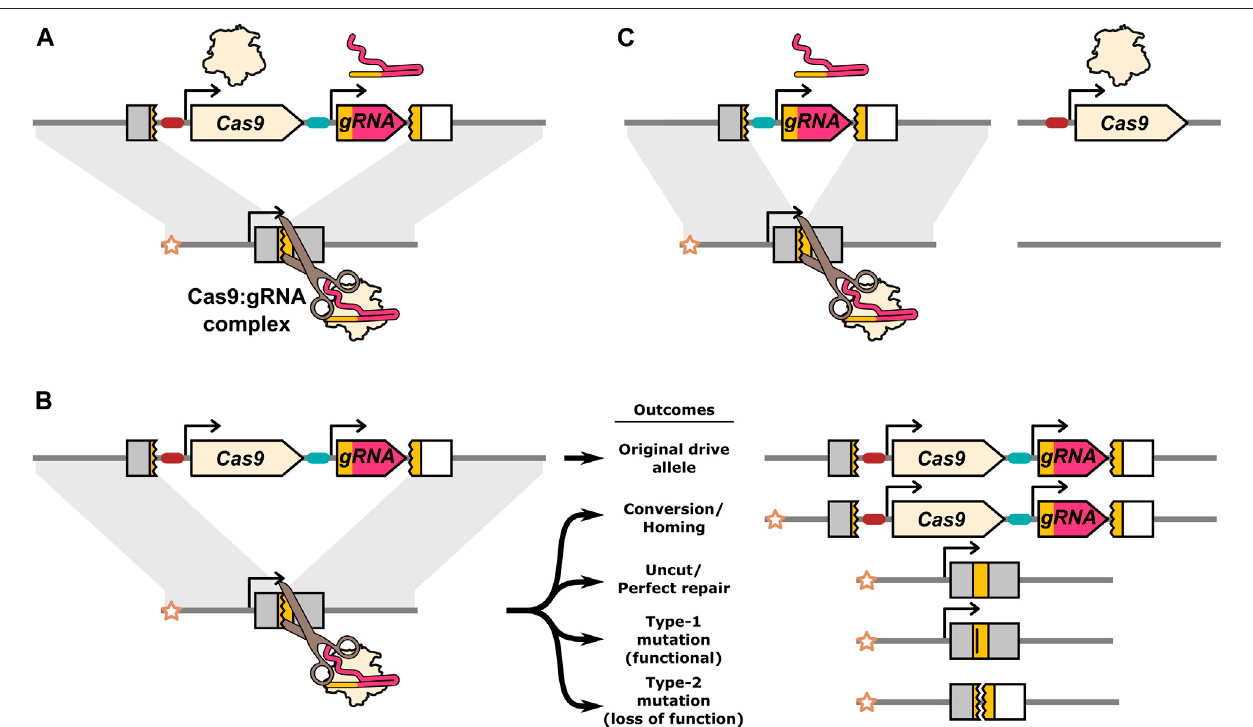
FIGURE 1 | Illustration of the Cas9: gRNA homing endonuclease gene drive inheritance biasing mechanism and potential DNA repair outcomes. (A) The drive expresses Cas9 and a gRNA which together form a complex that fi nd and cleave the target allele. (B) DNA breaks can be resolved by a range of different repair outcomes. Conversion occurs when HDR uses the homologous chromosome carrying the drive allele as a repair template. The star indicates the “ recipient ” chromosome, and allows the original drive allele to be distinguished from a drive allele produced by homing. Alleles that are cut and repaired perfectly, as well as uncutalleles,remainunconverted.Inadditiontoconversion,DNArepaircanalsoresultinmutationsinthetargetgene.Ifthespeci fi cmutationsdonotdisruptthefunction of the target gene they are classi fi ed as type-1. If the mutations do prevent normal function of the target gene they are classi fi ed as type-2. (C) A componentessential to theinheritancebiasingprocesssuchasthegRNAorCas9genecanbelocatedonaseparateelementproducinga “ split-drive ” con fi guration.ThegRNAtargetsequence in the endogenous target gene is indicated by a yellow colouring. The target gene is shaded grey, unless disrupted by the drive or type-2 mutations at which point it is shadedwhitetoindicateditslossoffunction.Type-1mutationslosethegRNAtargetsequence(indicatedbyaverticalbarintheyellowtargetsite),butremainfunctional.